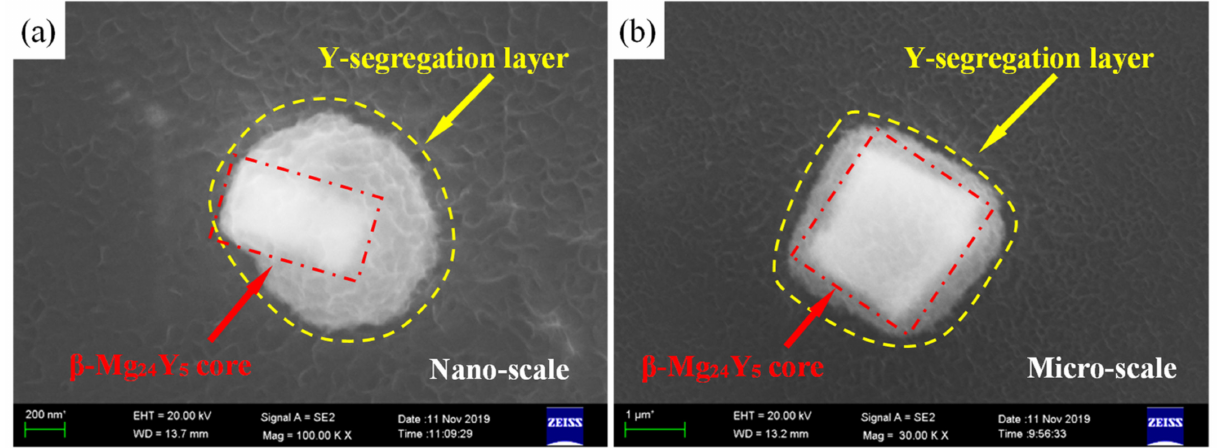
Figure 8. SEM micrographs of the secondary phases with Y-segregation layer of ( a ) nano-scale and ( b ) micro-scale of as-cast Mg-3Y